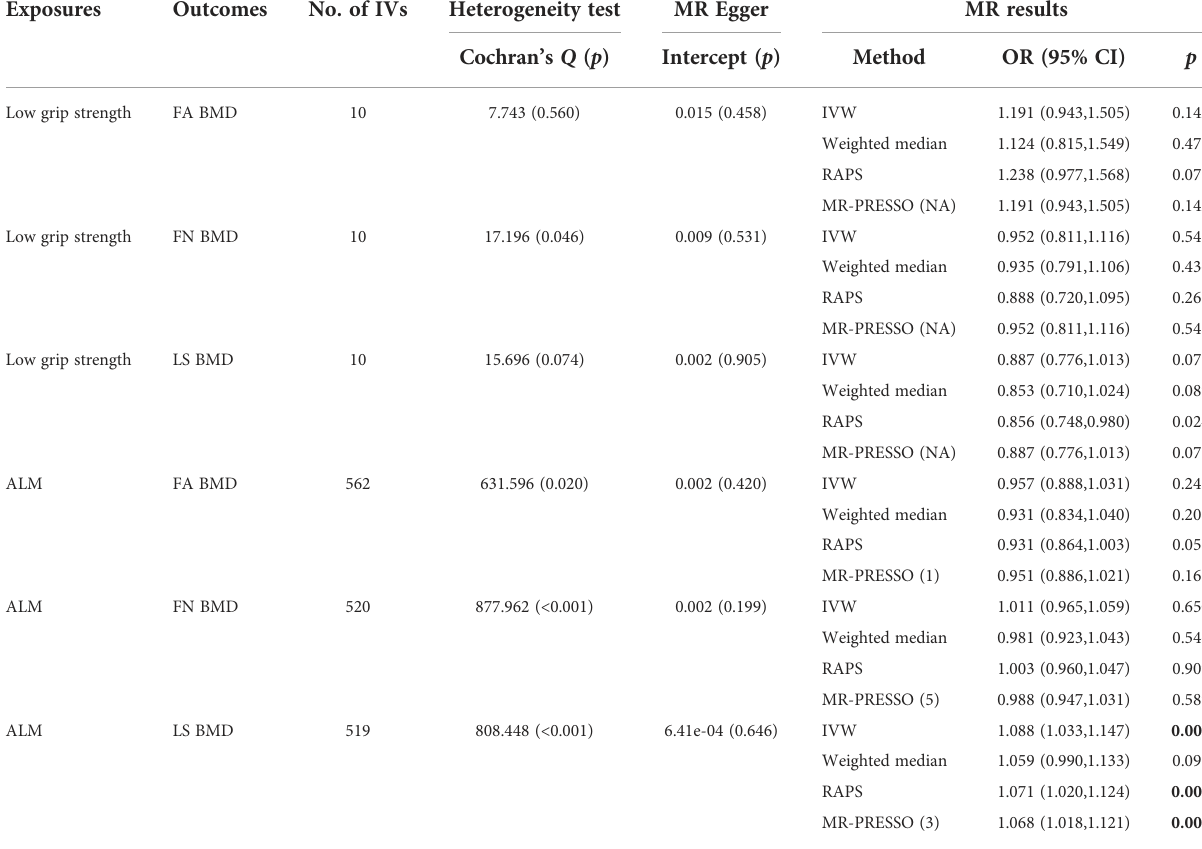
TABLE 2 Mendelian randomization estimates for sarcopenia-related traits on BMD with all selected IVs.